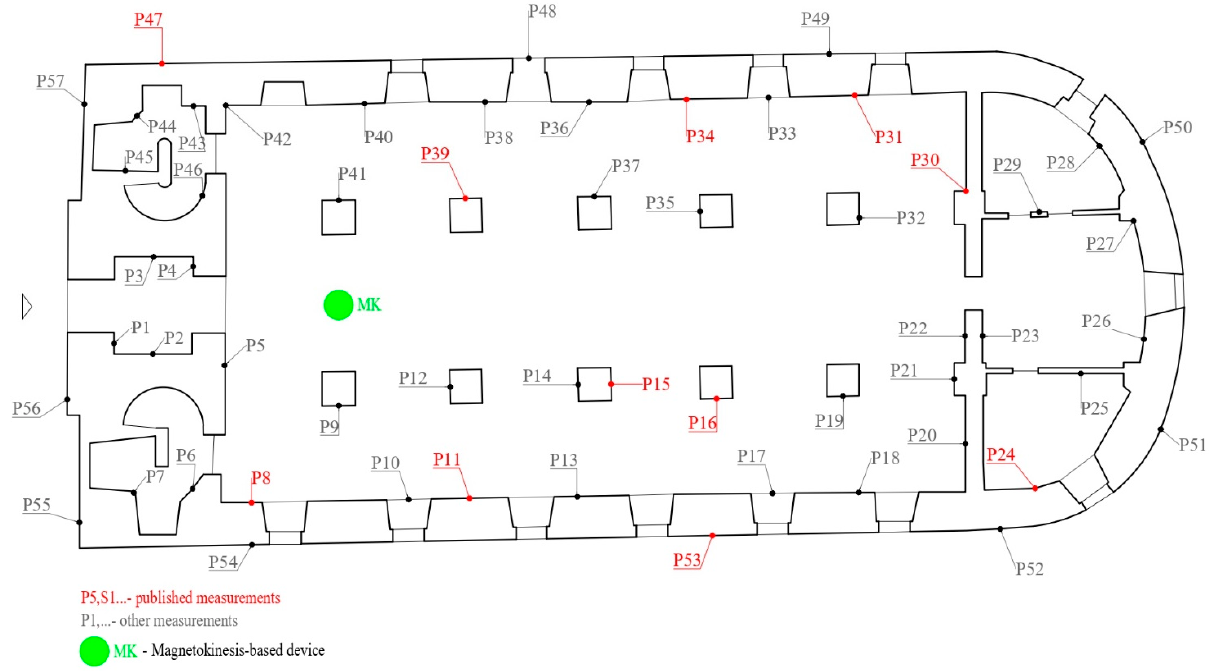
Figure 8. Humidity measurement points on a historic construction (3rd researched building).